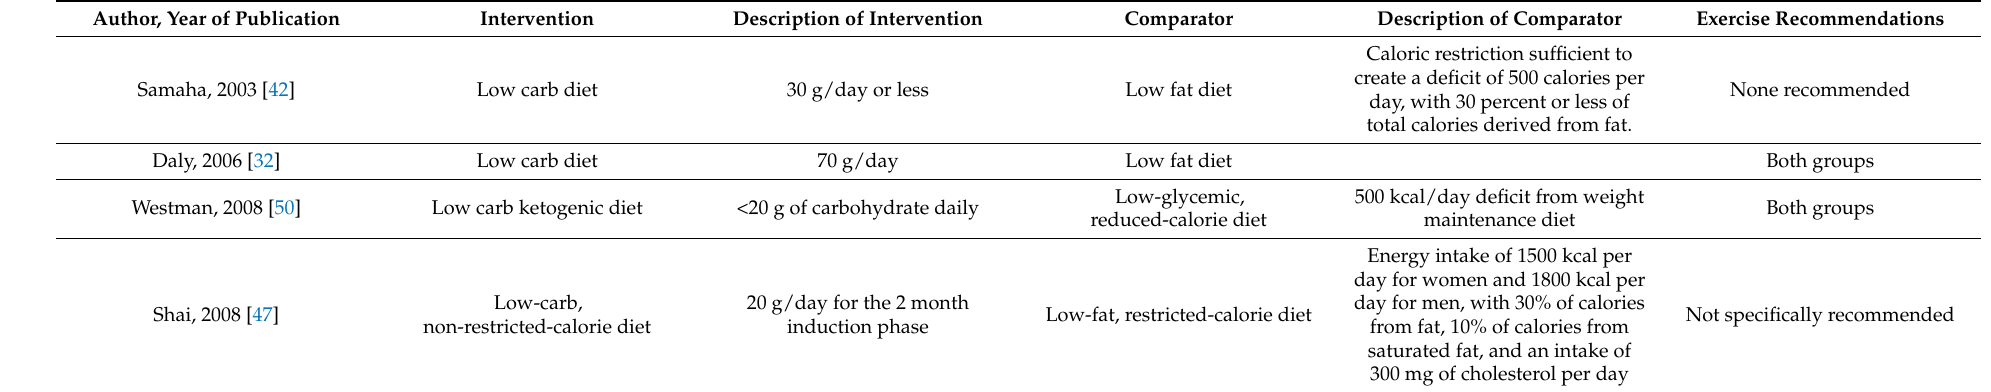
Table 2. Characteristics of interventions and comparators in included